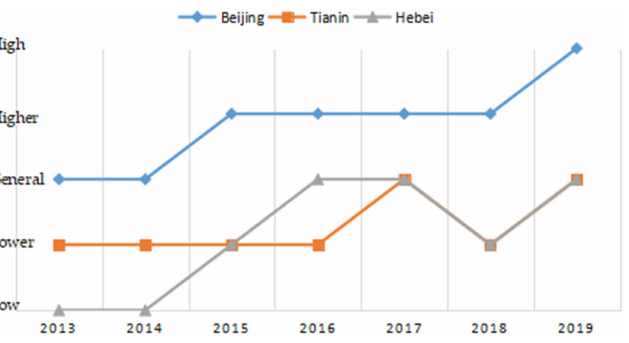
Figure 9. 2013–2019 Beijing-Tianjin-Hebei Regional Logistics Decarbonization Development Grade